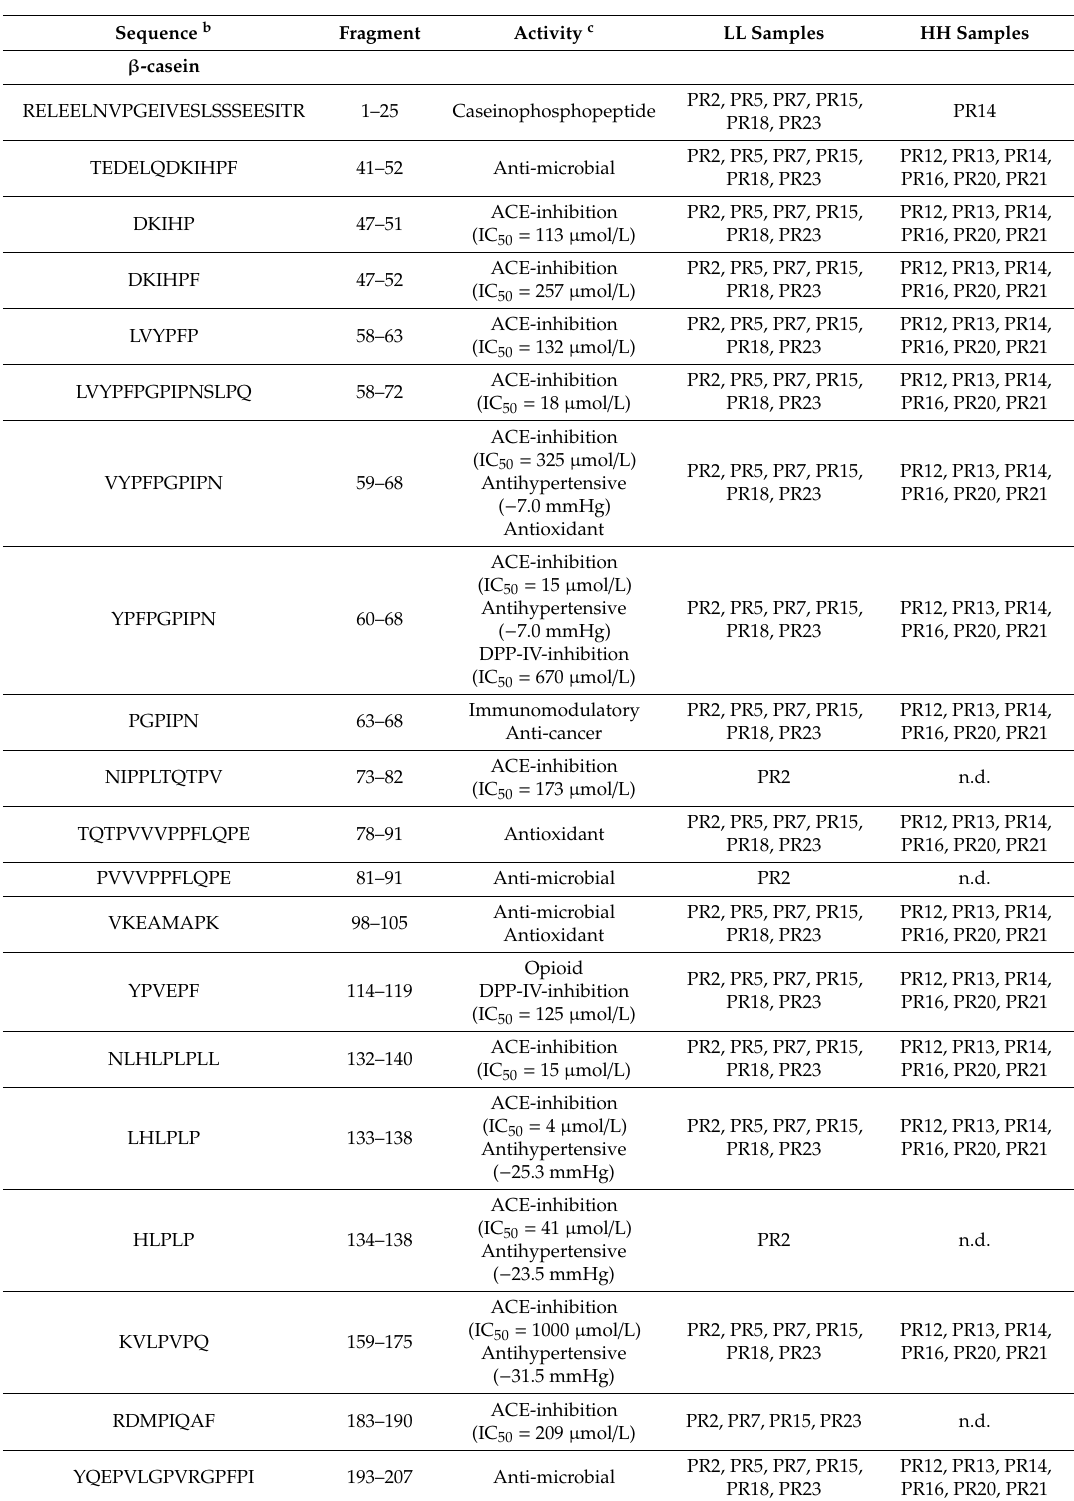
Table 1. List of the bioactive peptides found in the peptide fractions of Parmigiano Reggiano (PR) samples at 12 months of ripening a